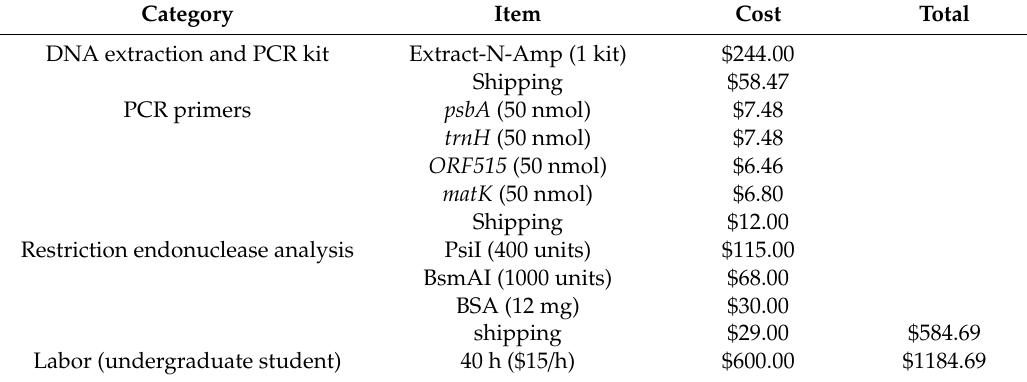
Table 1. Costs for analyzing 200 needle samples—the number that can be analyzed with an order of minimal quantities of items needed for DNA isolation, PCR amplification, and restriction-site analysis (using the trnG intron combined with the AvrII restriction endonuclease would reduce 200 possible samples to 100). After protocol optimization and troubleshooting performed during our study, we estimate labor at about 40 h. Category Item Cost Total DNA extraction and PCR kit Extract-N-Amp (1